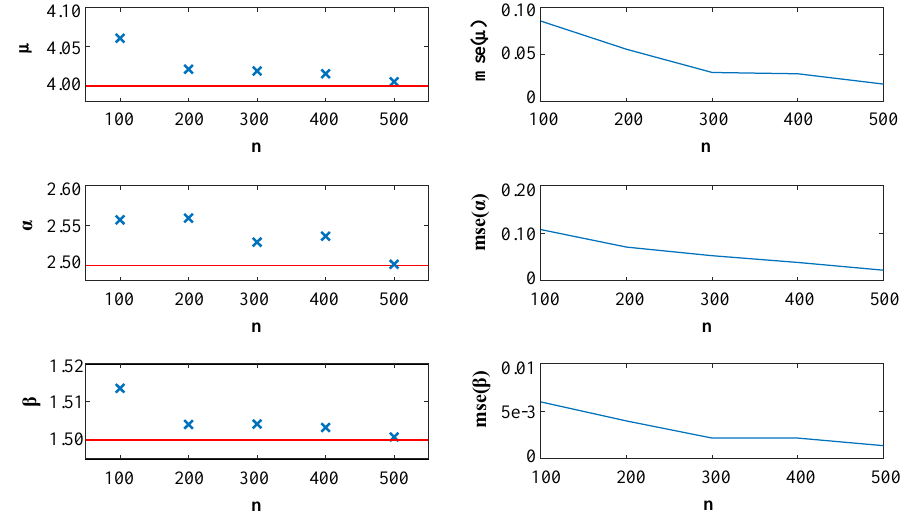
Figure 1. Parameter estimation and 𝑀𝑆𝐸 of the EME